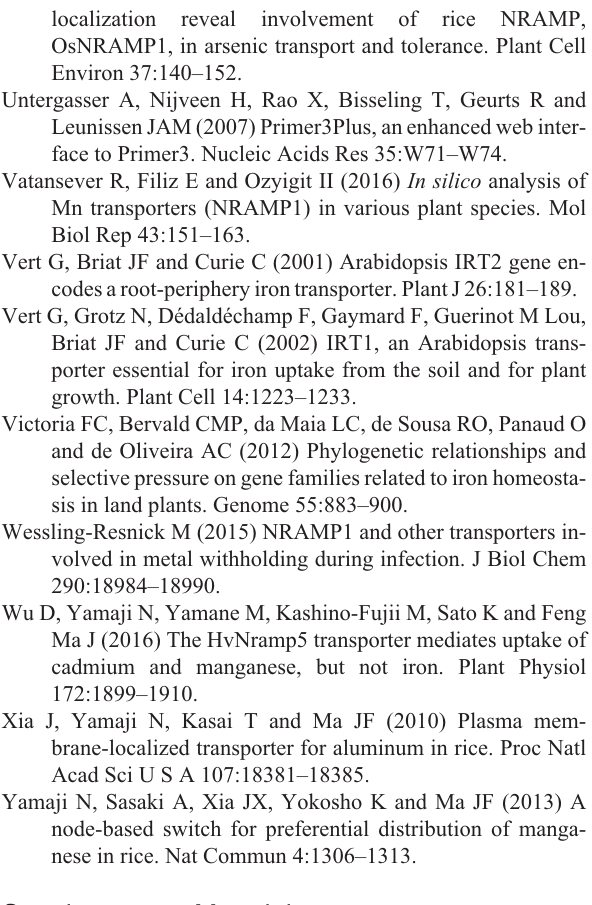
Figure S2 - Putative 3D structure of NRAMP transporter. Figure S3 - Expression levels of NRAMP genes in M. truncatula. Figure S4 - The expression of NRAMP genes in vegetative and reproductive tissues in soybean. Figure S5 - Phylogenetic tree of NRAMP genes in Fabaceae. Table S1 - Gene specific primers for P. vulgaris NRAMP